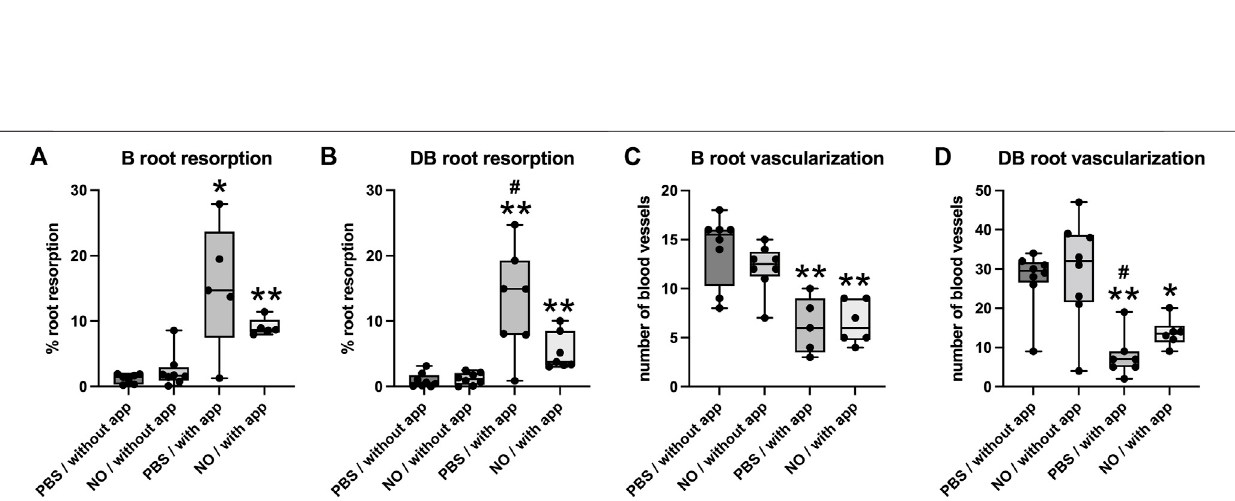
FIGURE 6 | Inhibition of molar tooth movement coincides with NO release from N-nitrosothiol nanoparticles. (A) NO in vitro release pro fi le from nanoparticles. ResultsshowaninitialburstreleasefollowedbystableNOreleaseuntilday4uponwhichNOreleasedecreasestonon-measurablelevelsbyday7. (B,C,D) Mesialmolar toothmovementsondays1 – 6 (B) ,6 – 12 (C) and12 – 18 (D) .Whiskerplotsshowingmedians,interquartilerange,minimumandmaximumvaluesareshown.Mesialmolar tooth movement is signi fi cantly inhibited by over 50% during days 1 – 6 of the experimental period. * p < 0.001. No signi fi cant inhibition of mesial molar tooth movement is seen during days 6 – 12 or days 12 – 18 of the experimental period.